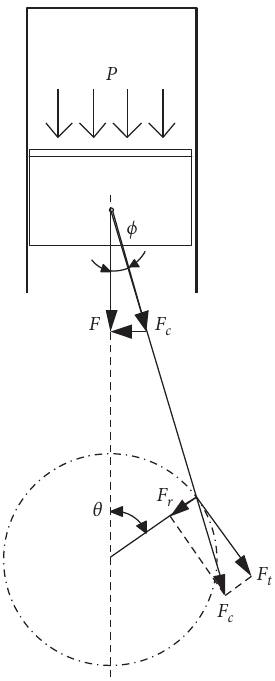
Figure 2: The force diagram of a single crank link